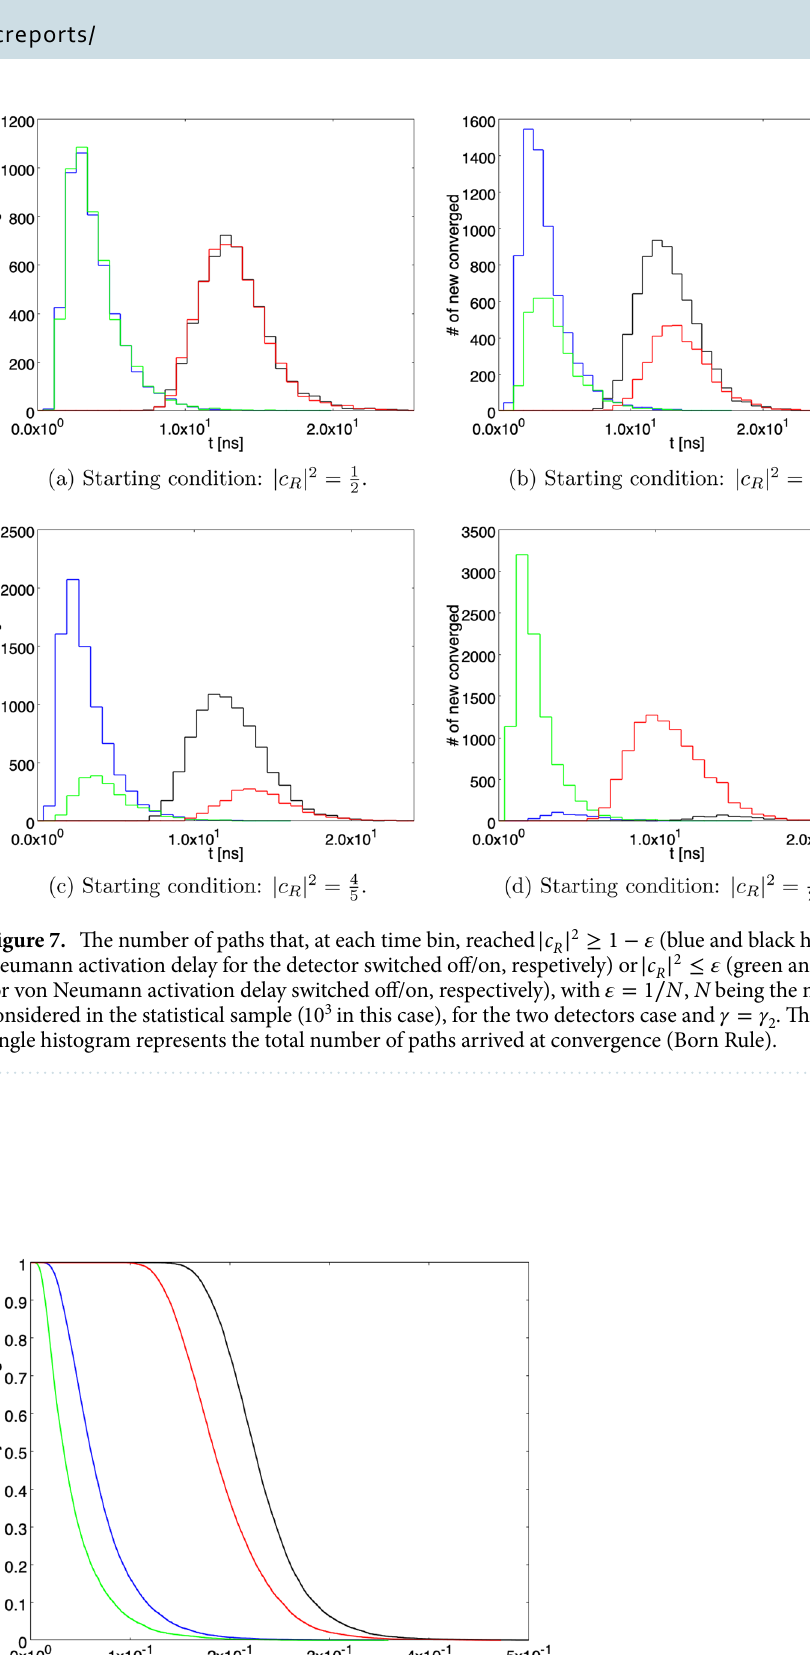
Figure 8. Persistence of the superposition. Fraction of paths with 𝜀 ≤ correspond to the starting conditions The red and black curves represent the same situation with von Neumann activation. The setup with 𝛾 = 𝛾 1 and a single detector has been